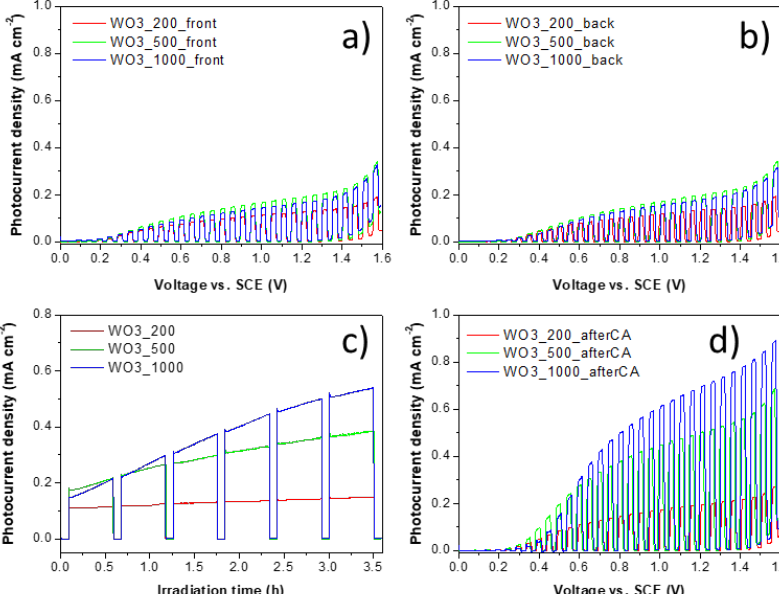
Figure 2. Effect of the WO 3 film thickness on chopped Linear Sweep Voltammetry (LSV) curves under ( a ) front and ( b ) back irradiation of as-prepared samples; ( c ) chronoamperometry (CA) stability test at 1.0 V vs. SCE; ( d ) chopped LSV curves under back irradiation recorded after CA tests (panel c ). All measurements were made in a 0.5 M Na 2 SO 4 electrolyte solution under simulated AM 1.5 G solar irradiation.